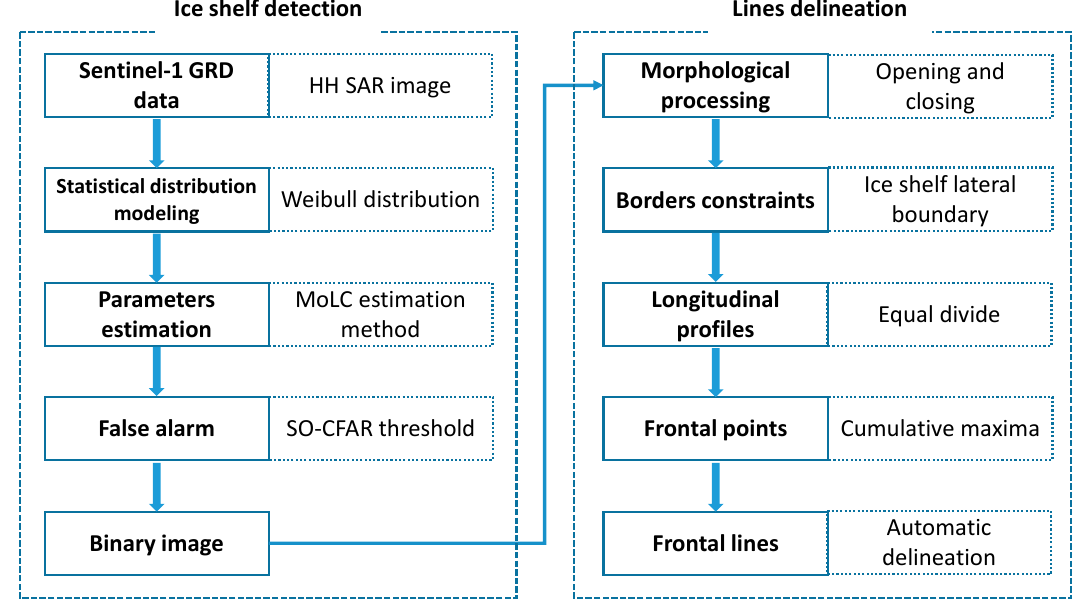
Figure 1. Flowchart of the frontal lines detection algorithm. The left panel is for the ice shelf detection and the right panel is for delineating frontal lines.